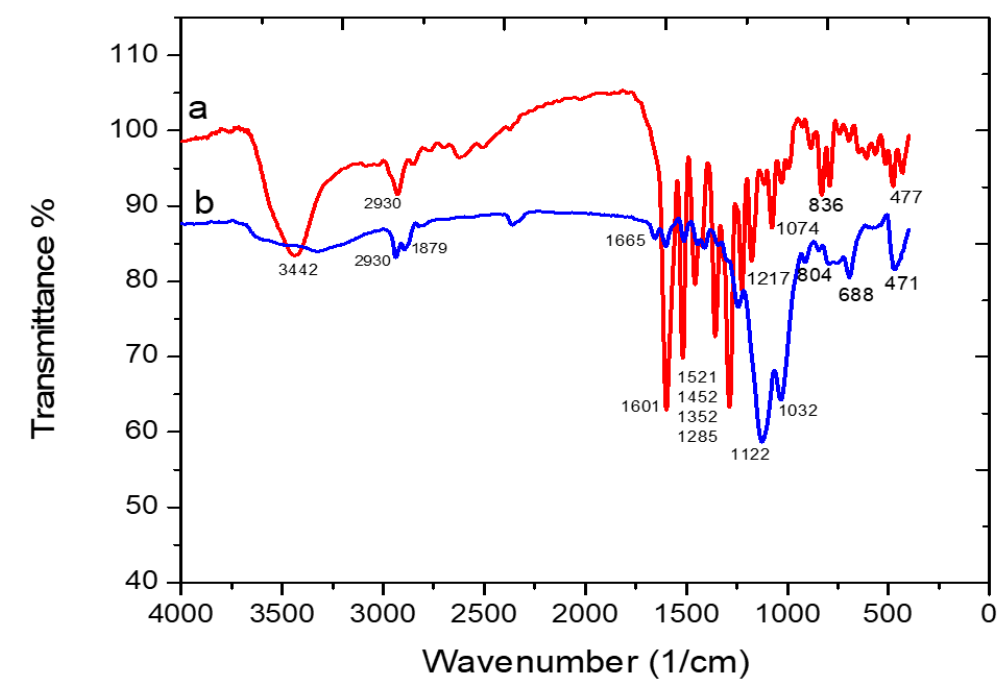
Figure 1. FTIR spectra of (a) free Schiff base and (b) adsorbent 1 .